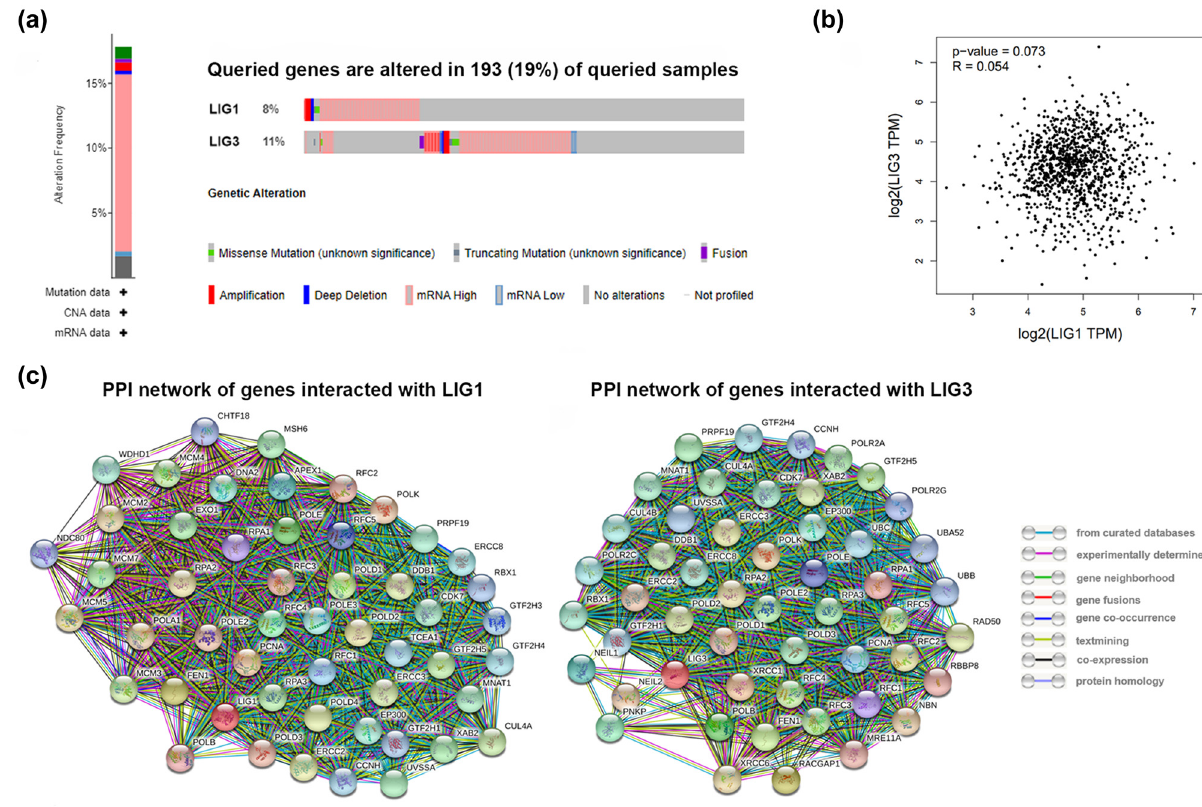
Figure 5: Alterations of LIG1 and LIG3 in BC patients and the protein – protein interaction network. ( a ) Alterations of LIG1 and LIG3 in BC ( cBioportal ) . ( b ) No signi fi cant correction between LIG1 and LIG3 in BC ( GEPIA ) . ( c ) Protein – protein interaction networks for LIG1 and LIG3 with the 50 most frequently interacted